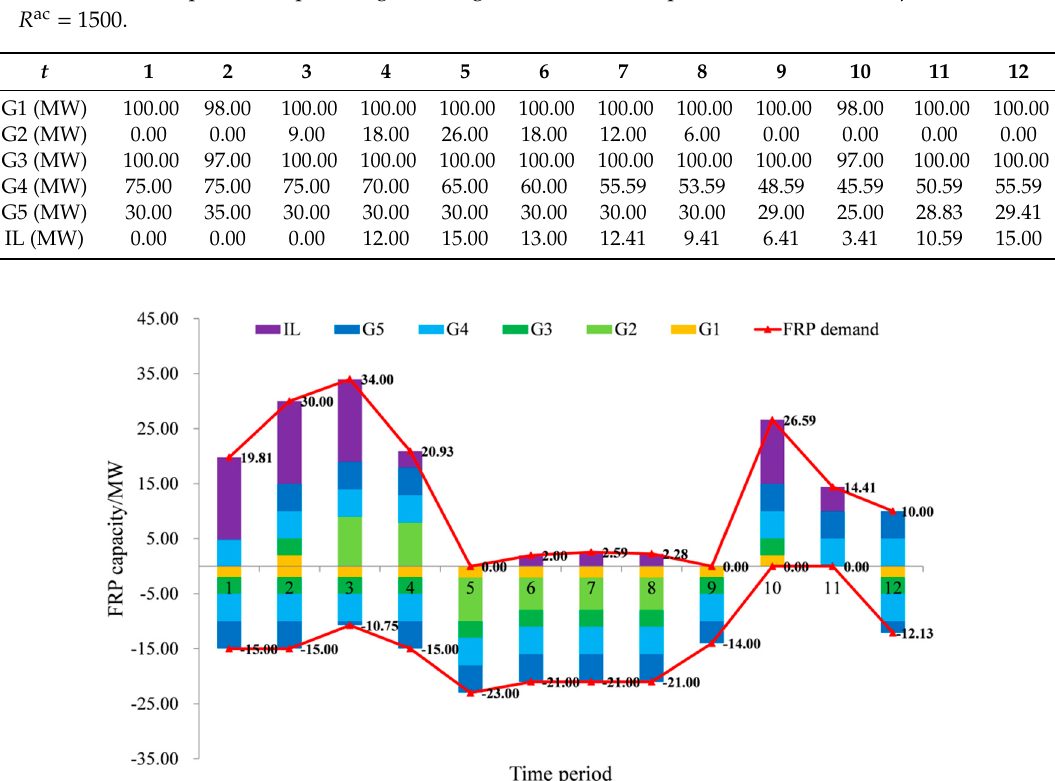
Figure 4. Actual demand and supply of flexible ramping products (FRP).